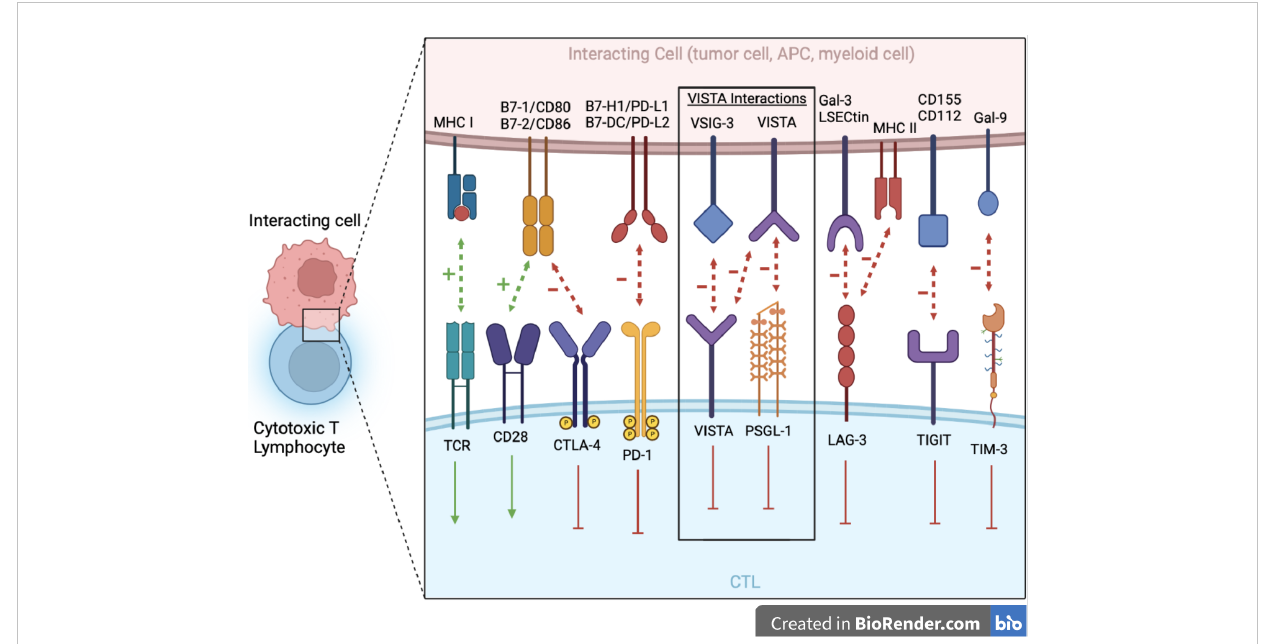
FIGURE 1 The major NCRs in the Ig superfamily are shown at the junction between the CTL and interacting cell (e.g., tumor cell, APC, myeloid cell, etc.). VISTA serves dual immunosuppressive roles as both a ligand on myeloid cells/APCs with PSGL-1 being its receptor on CTLs and a receptor on CTLs with VSIG-3 as its ligand. Additionally, there is potential for VISTA – VISTA homotypic interaction. Blocking antibodies toward these targets is showing great promise in immunotherapy. APCs, antigen presenting cell; CTL, cytotoxic T lymphocyte; Gal-3, galectin-3; Gal-9, galectin-9; LAG-3, lymphocyte activation gene 3; LSECtin, liver and lymph node sinusoidal endothelial cell C-type lectin; MHC I, major histocompatibility complex class I; MHC II, major histocompatibility complex class II; NCR, negative checkpoint receptors; PSGL-1, P-selectin glycoprotein ligand 1; TCR, T cell receptor; TIGIT, T cell immunoglobulin and immunoreceptor tyrosine-based inhibitory motif domains; TIM-3: T cell immunoglobulin mucin-3; TME, tumor microenvironment; VSIG-3, V-set and Ig domain-containing